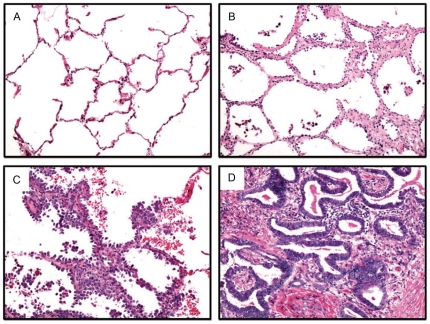
Lung and lesion histology.Haematoxylin and eosin-stained sections of (A) Adjacent non-tumor lung (B) Atypical adenomatous hyperplasia (C) Adenocarcinoma in situ (D) Lung adenocarcinoma, all at 100× magnification.